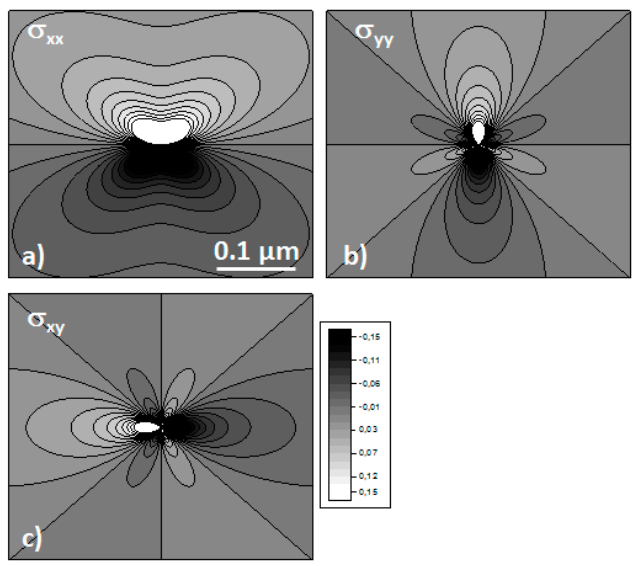
Figure 2. Plots of the stress components σ xx ( a ), σ yy ( b ), and σ xy ( c ) of an edge dislocation. The scale shows the stress in GPa.